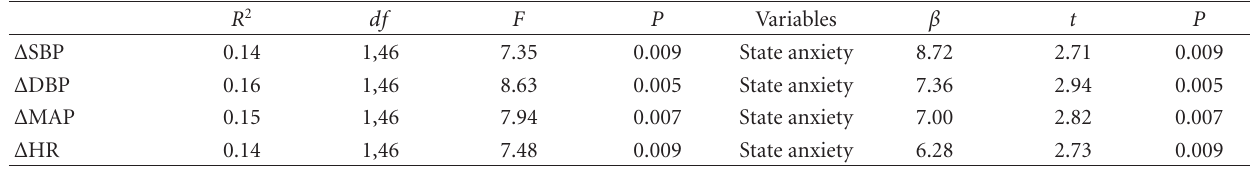
Table 3: Parsimonious linear regression models for cardiovascular reactivity to cold pressor test.